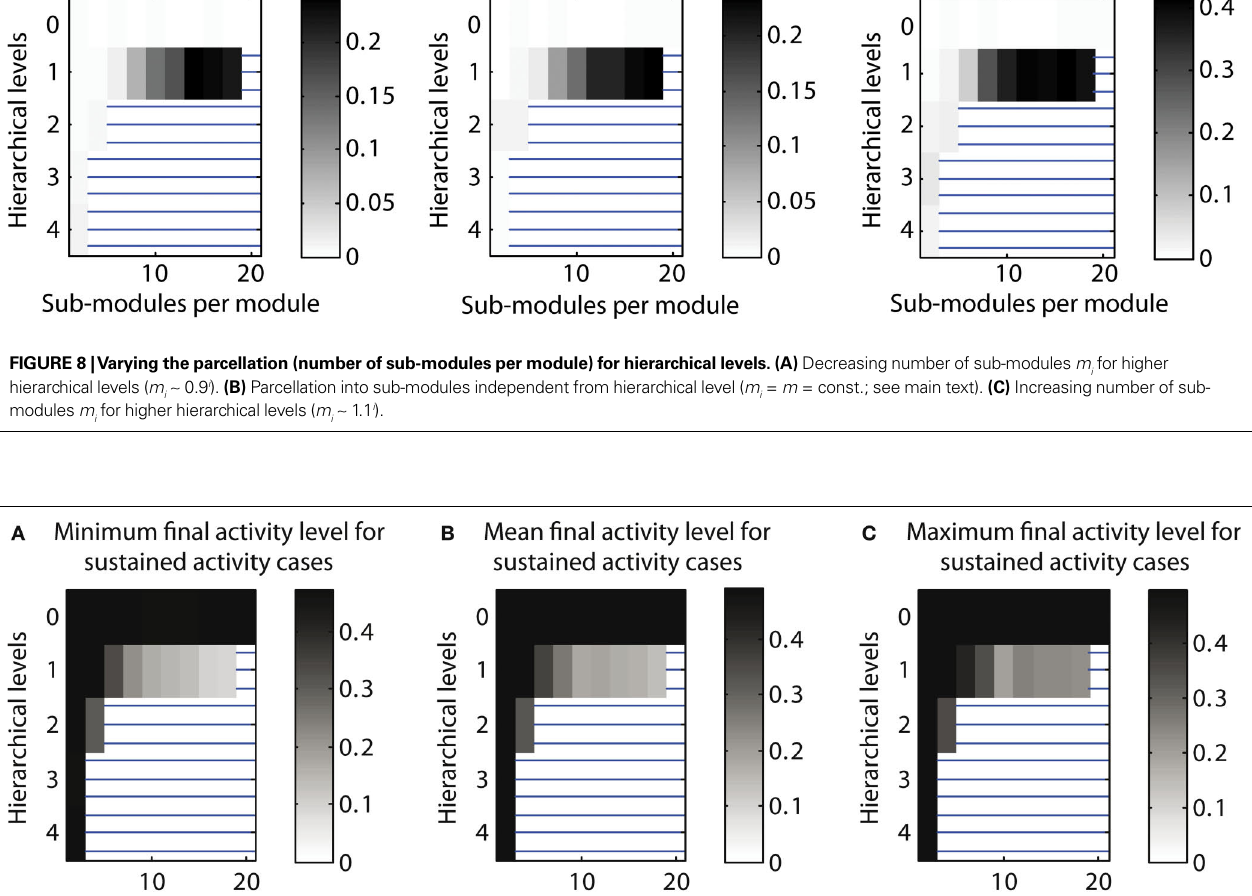
FIGURE 9 | Final activity for n = 20 runs classifi ed as sustained activity. (A) Minimal fi nal activity level. (B) Average fi nal activity level. (C) Maximum fi nal activity